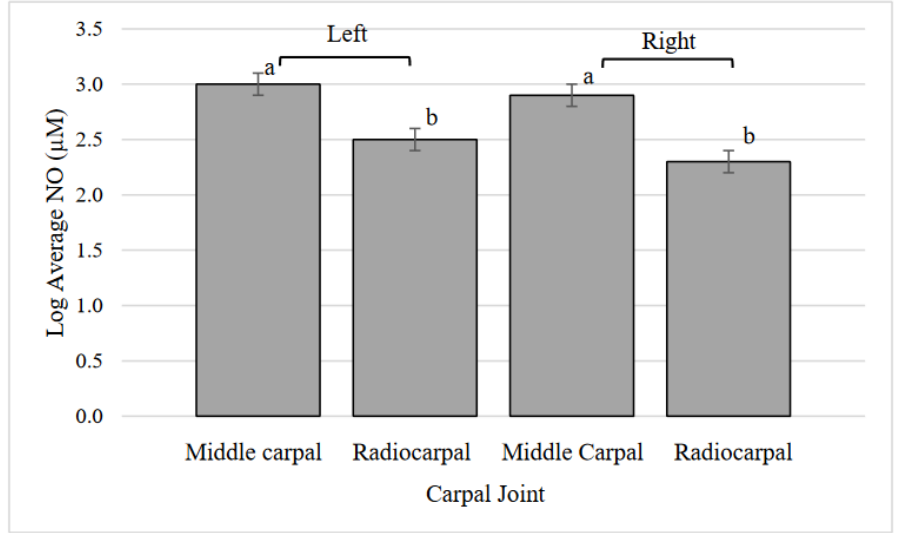
Figure 5. Log transformed average nitric oxide (NO) concentration in the middle carpal and radiocarpal joints. a, b Values that lack common superscripts differ ( p < 0.0001).